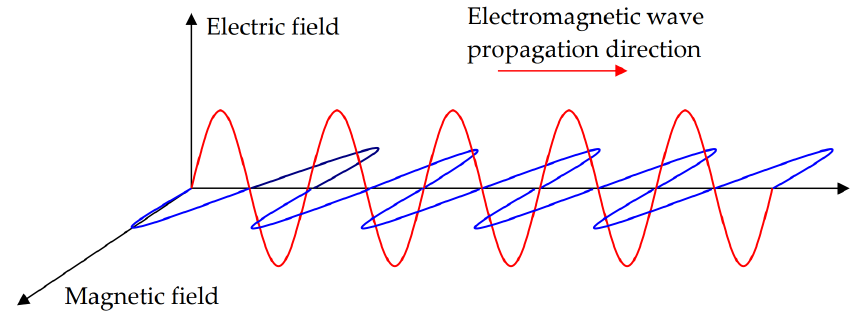
Figure 1. Electromagnetic Wave Propagation in Medium.